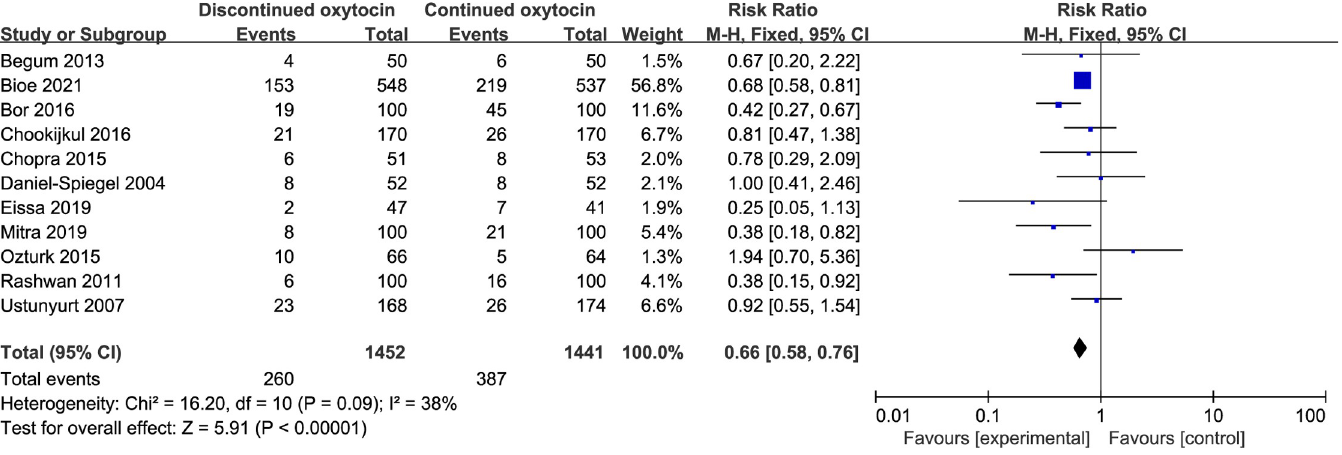
Fig 10. Pooled results for each outcome.